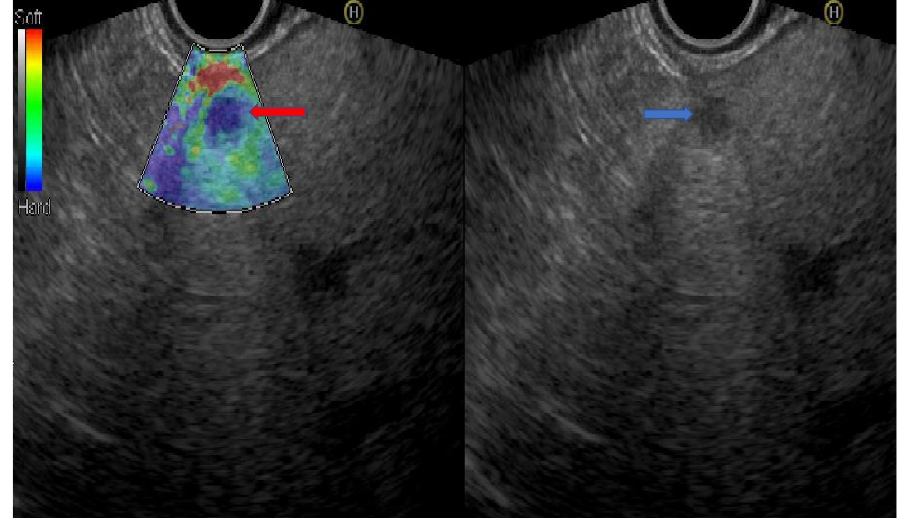
Figure 1. A patient with metastatic pancreatic adenocarcinoma to the liver. The blue arrow shows the liver metastasis by linear echoendoscope. The red arrow shows the lesion by real-time EUS-elastography in a blue color reflecting the hardness and stiffness of the lesion (the picture was supplied from the gastroenterology department at Galilee Medical Center).